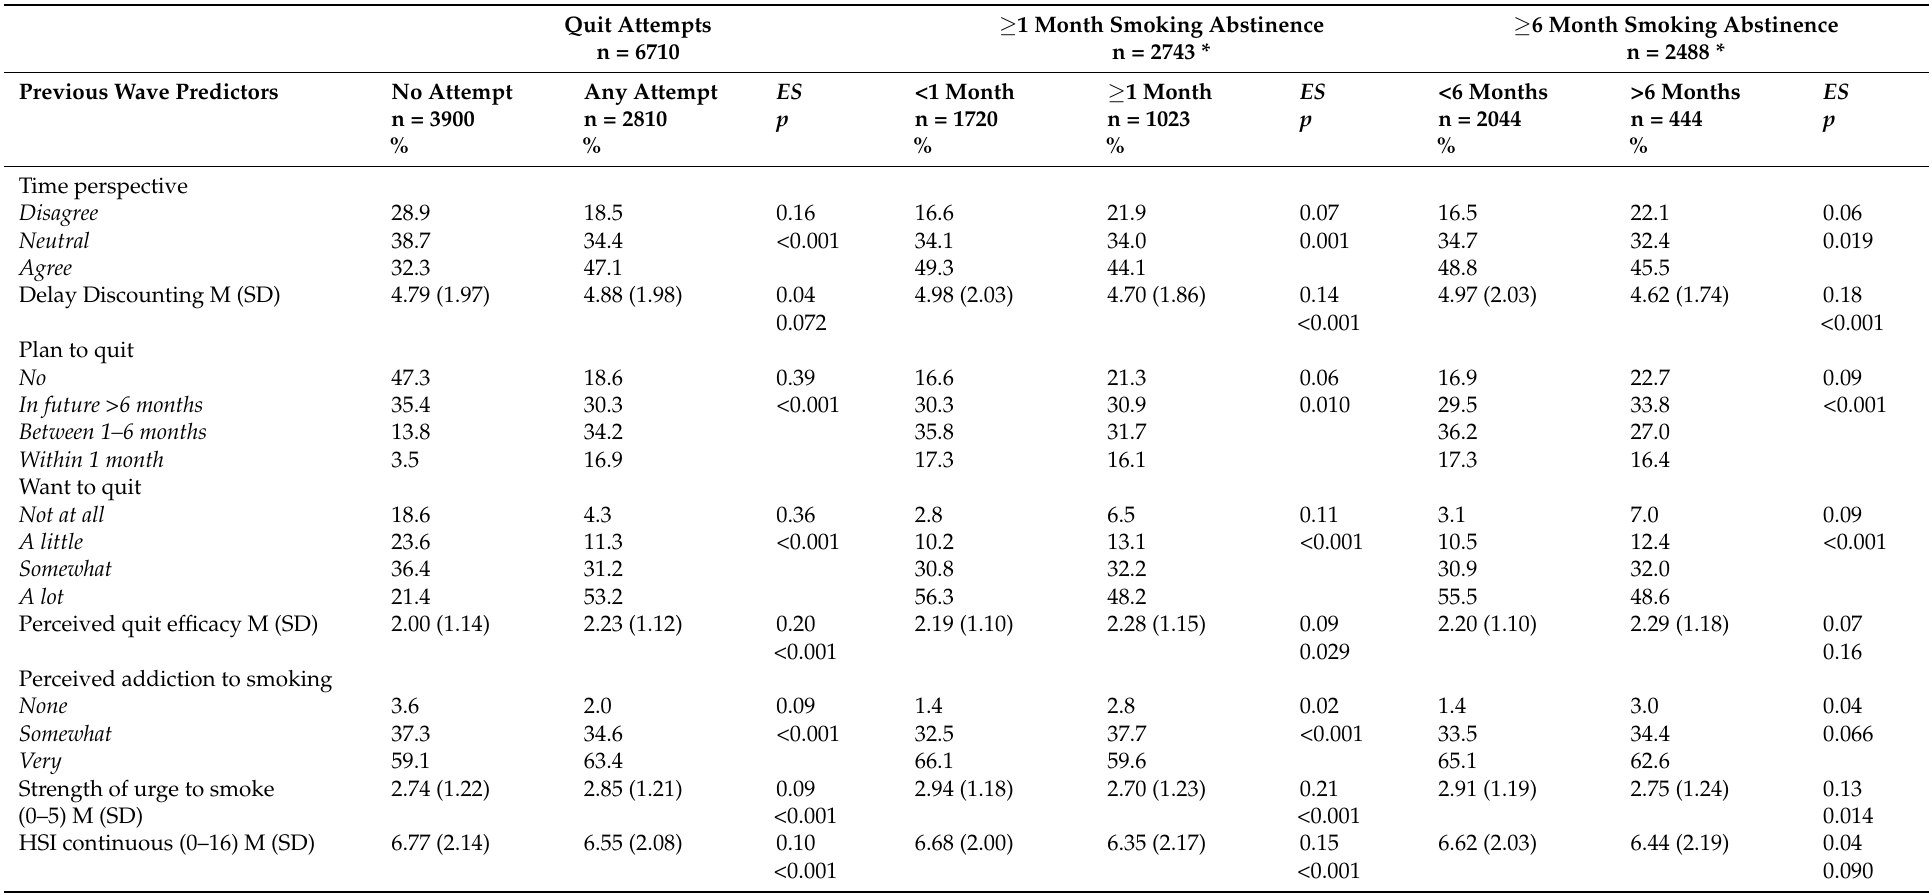
Table 1. Delay discounting, time perspective, motivational, dependence and demographic characteristics by quit attempts and for >1 month and ≥ 6 months